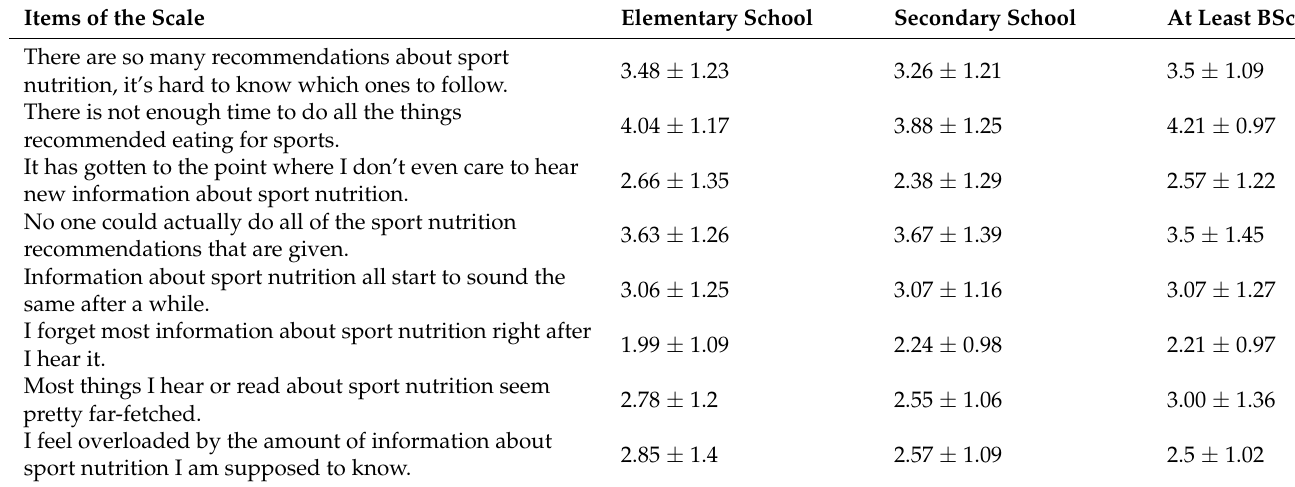
Table 5. Average and standard deviation of responses by